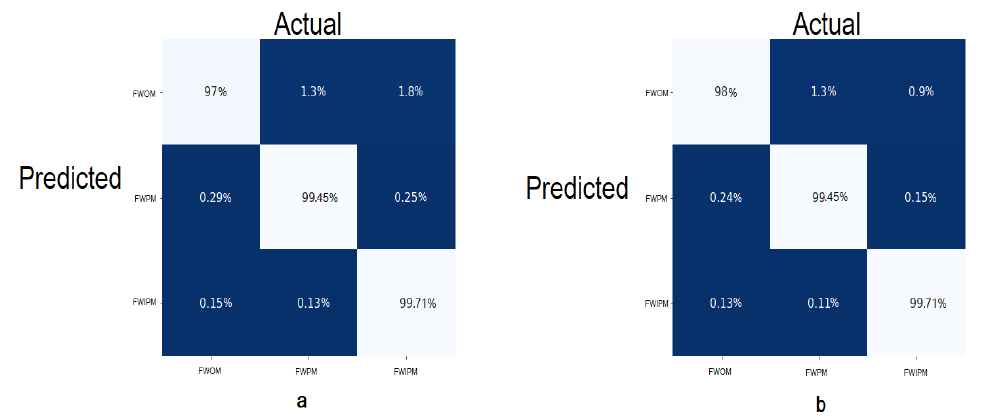
Figure 14. The confusion matrixes of two models: ( a , b ) show the confusion matrix for the identi- fication and classification of face mask in three classes FWOM (Face Without Mask), FWPM (Face with Proper Mask), and FWIPM (Face With Improper Mask) by using the CNN and ResNet-50 models, respectively.